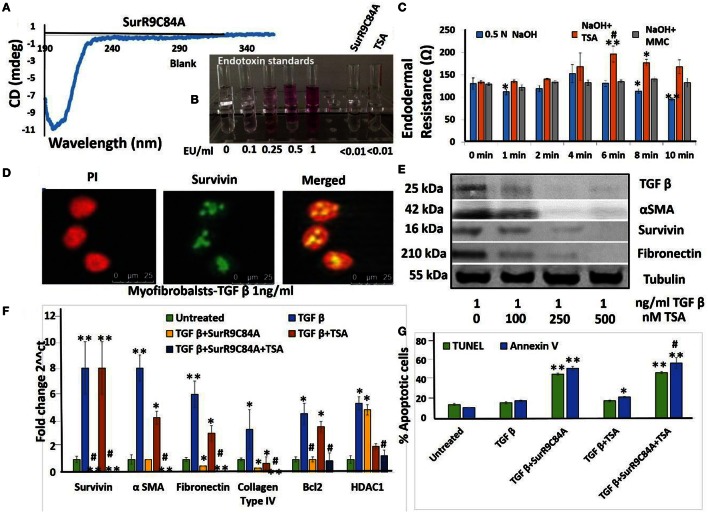
Survivin and HDAC inhibitors inhibit myofibroblast in vitro. (A) The CD spectral analysis confirmed a coiled structure of SurR9-C84A. (B) Both TSA and SurR9-C84A were found to be free of endotoxins. (C) TSA showed better healing activity than MMC using TEER assay. (D) Transformation of keratocytes to myofibroblasts with TGF-β (1 ng/mL) induces survivin over-expression. (E) TGF- β insult led to transformation of human corneal keratocytes into myofibroblast cells with elevated expressions of α SMA, fibronectin, type IV collagen, and HDAC1 which were effectively lowered by combination of TSA and SurR9C84A. (F) TSA led to a dose dependent decrease in α SMA and fibronectin mRNA expression levels, while SurR9C84A in combination with TSA downregulated the expression of α SMA, survivin, fibronectin, collagen type IV, Bcl2, and HDAC1 mRNA expressions in myofibroblast cells. (G) Combination of TSA and SurR9C84A was highly efficient in inducing apoptosis in myofibroblast cells. Data represents mean ± SEM. Experiments were repeated 3 times in triplicates. Representative images have been presented. **P < 0.01; *P < 0.05; treatment vs. control, #Most effective treatment.